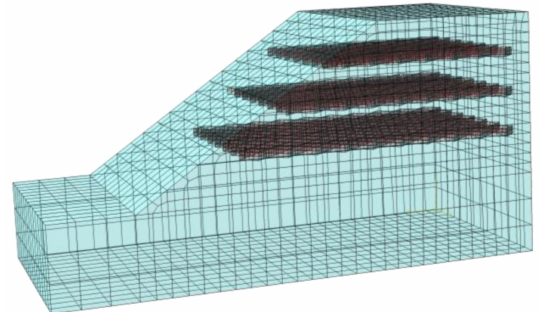
Figure 5. Embankment and reinforced element mesh